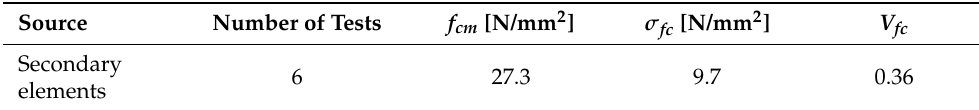
Table 1. First stage sample parameters for concrete compressive strength.